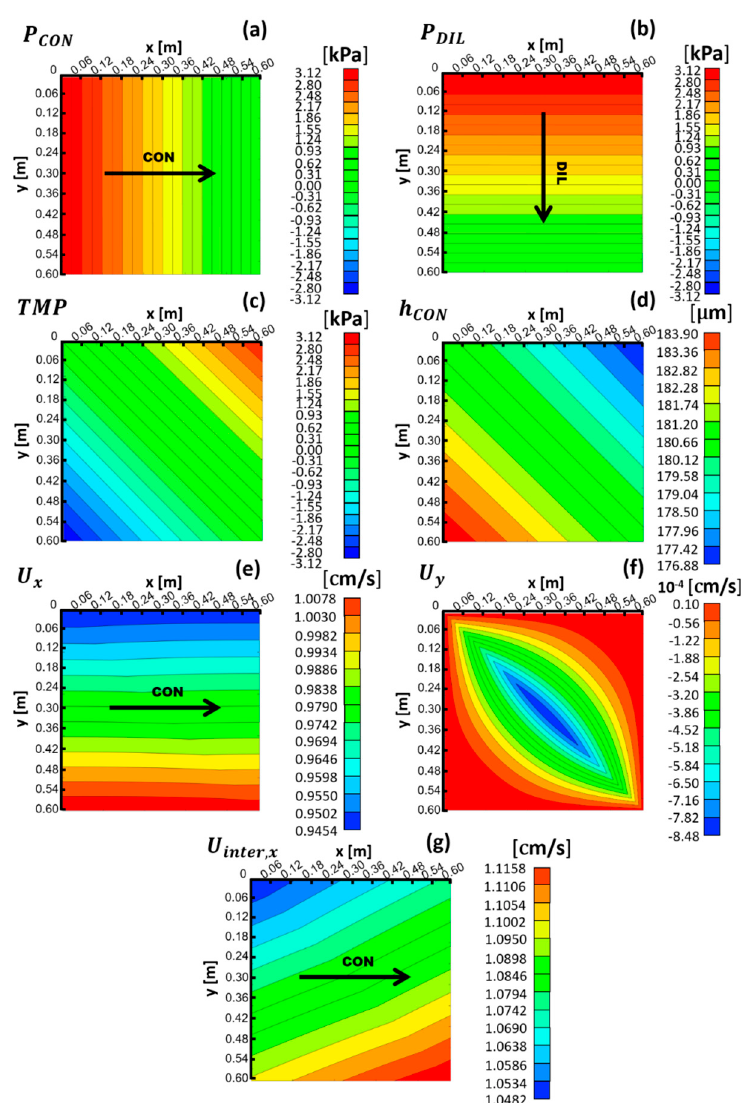
Figure 10. Results for a cross flow stack of 0.6 m sides at P in − P out = 3.12 kPa ( U s ≈ 1 cm / s) in the presence of membrane deformation: relative pressure maps for the CON ( a ) and DIL ( b ) channels, TMP ( c ), and concentrate channel equivalent height ( d ), superficial velocity components along the x ( e ) and y ( f ) directions, and interstitial velocity along the x direction ( g ).